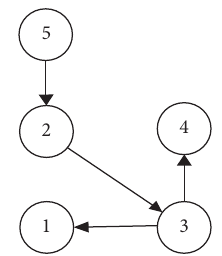
Figure 1: Communication topology.